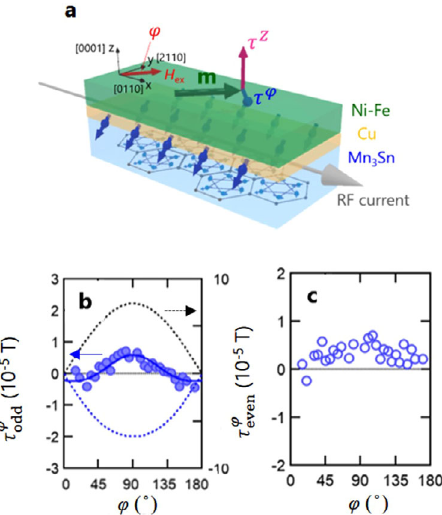
Fig. 4 Spin-torque FMR measurements in Mn 3 Sn/Cu/Ni-Fe trilayer. a Measurement setup for ST-FMR in Mn 3 Sn/Cu/Ni-Fe trilayer. The red and blue arrows on the respective top and bottom surfaces of the Mn 3 Sn stack indicate spin accumulation. The red and blue arrows on the Ni-Fe magnetization m correspond to out-of-plane torque τ z and in-plane torque τ φ . b , c odd-( b ) and even-( c ) components of τ φ as a function of the in-plane m direction φ . Blue (Black) dashed line corresponds to τ φ due to the STT of the conventional SHE (FLT of the